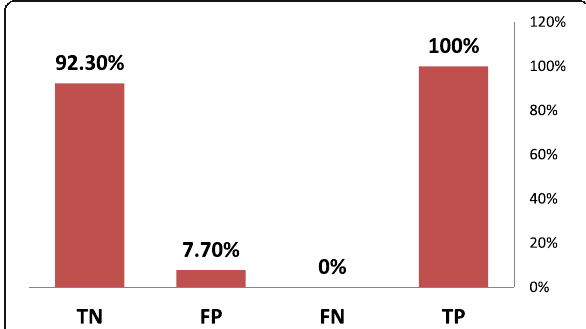
Fig. 7 Association between combined digital breast mammography, tomosynthesis and breast ultrasound findings, and final diagnoses in the studied